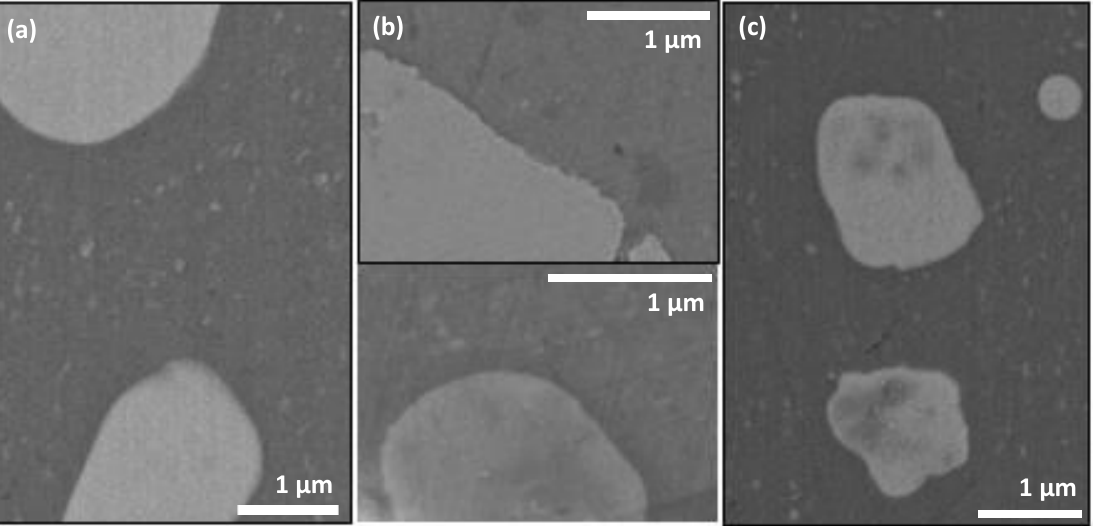
Figure 2. SEM images of as-prepared one-layer samples 1 ( a ), 2 ( b ), and 3 ( c ). All the surfaces are coated with one layer ODTMS coating. No traces related to electrochemical corrosion are seen on the surfaces. In panel ( b ), interface between two intermetallic particles (Al-Cu-Fe-Mn and Al-Cu-Mg types, top and bottom, respectively) and Al matrix are shown, both being